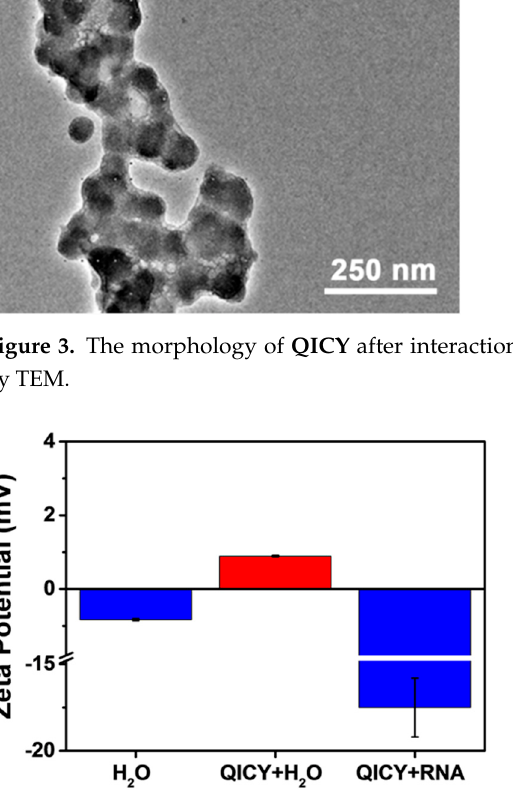
Figure 4. The zeta potentials of ultrapure water, QICY in ultrapure water, and QICY after interaction with RNA in ultrapure water.